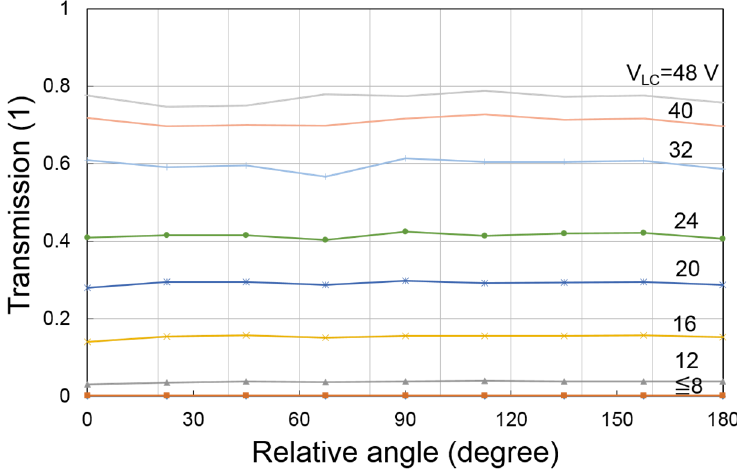
Figure 8. Transmission as a function of the relative angle. The sample was rotated at the experiment but this is equivalent to the light polarization rotation. Sample: